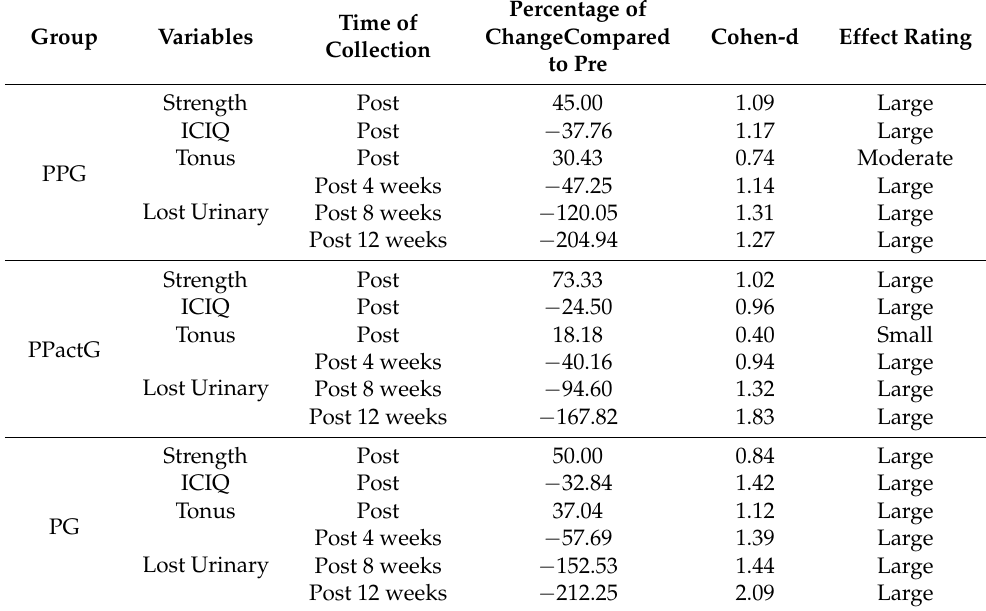
Table 5. The magnitude of differences between groups.